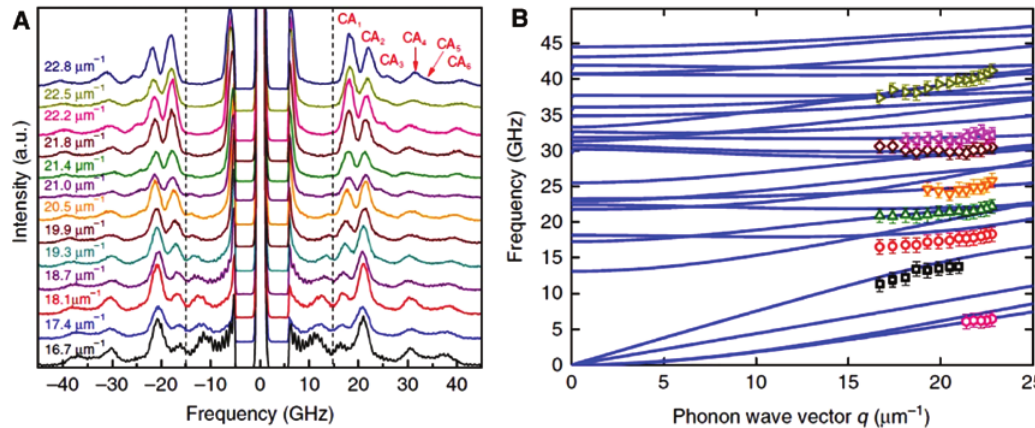
Figure 7: Brillouin scattering of nanowires. (A) Brillouin spectra of 122 nm diameter GaAs nanowires at different optical wavelength. (B) Phonon dispersion relation of 122 nm and experimentally obtained frequencies. The dispersion relations include both the dilatational, torsional and flexural modes. Adapted from